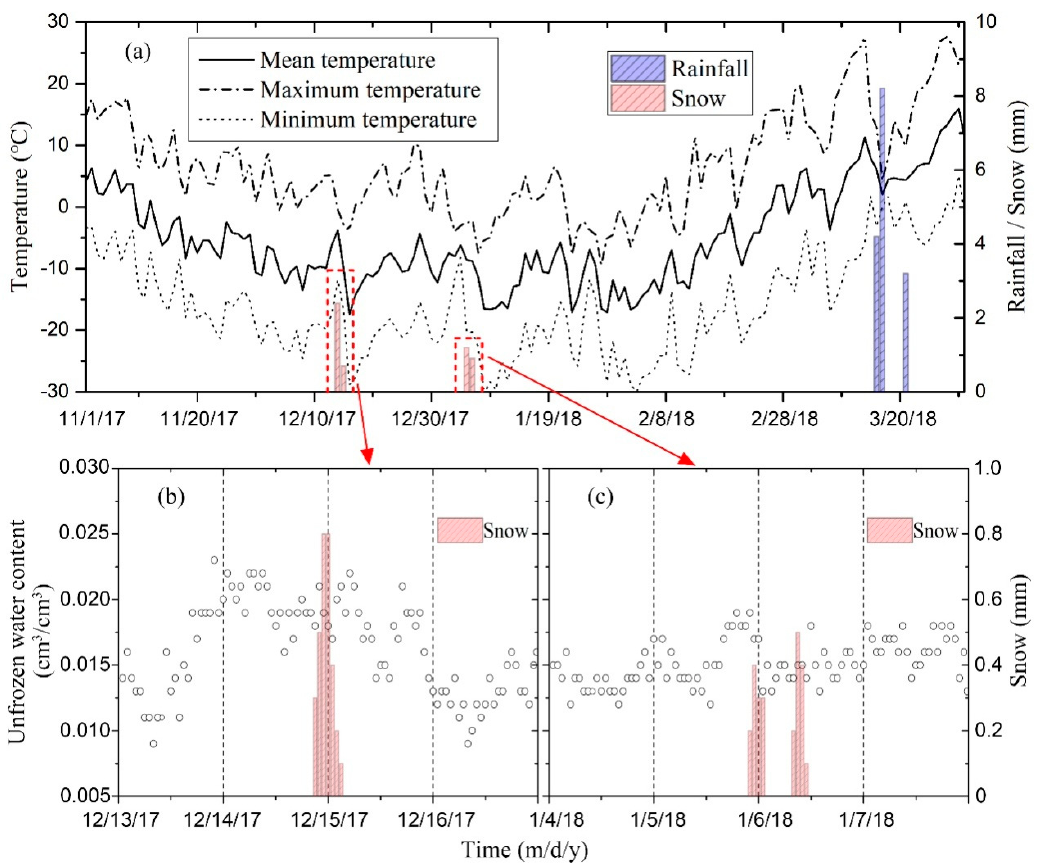
Figure 2. ( a ) Measured air temperature, rainfall, and snow during the period from November 2017 to March 2018 at the study site; and ( b , c ) unfrozen water content at the 10 cm depth during two snow periods.